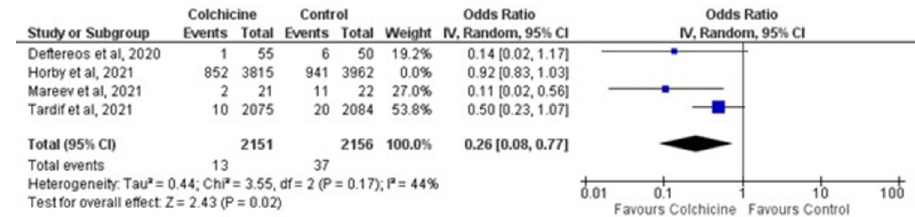
Fig 5. Forest plot for leave-one-out sensitivity analysis of colchicine on mechanical ventilation in COVID-19 patients. Blue squares and their corresponding lines are the point estimates and 95% confidence intervals per each study. Black diamonds represent the pooled effect estimate.